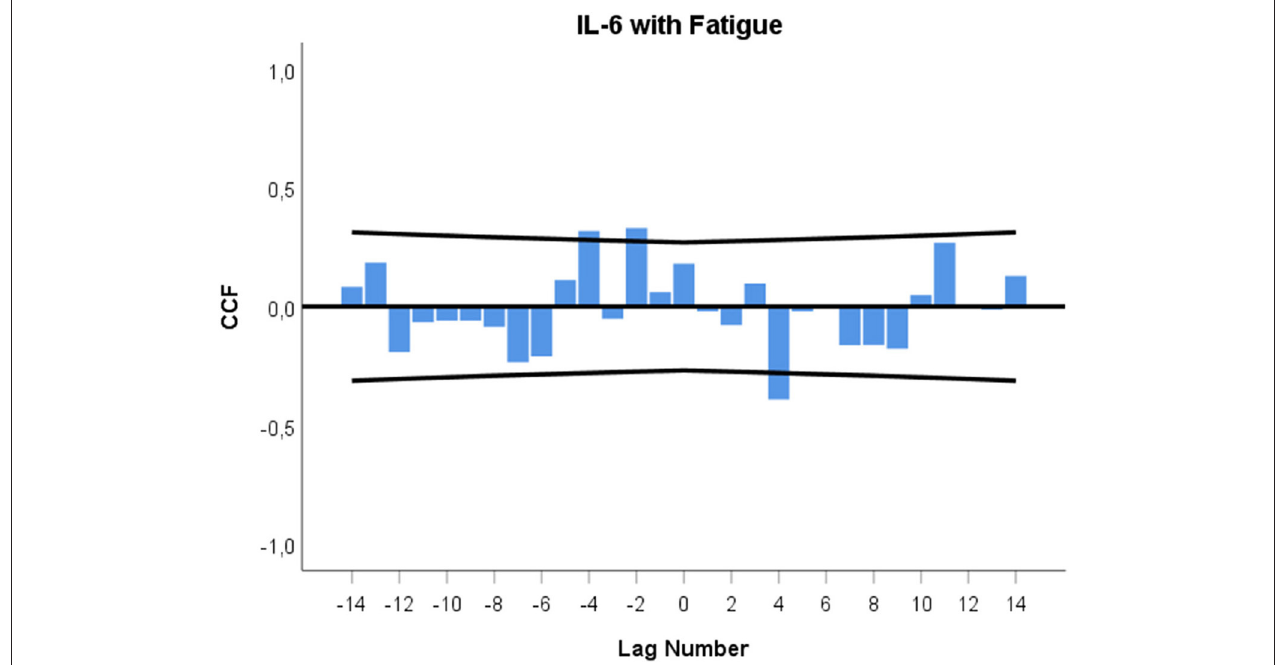
FIGURE 5 | Cross-correlation function (CCF) between urinary IL-6 concentrations and fatigue levels. Each lag represents a time interval of 12h. Cross-correlation coefficients (bars) reaching the upper or lower confidence limits (lines) are significant at p < 0.05. A positive lag significance means that IL-6 changes precede fatigue changes. A negative lag significance means that fatigue changes precede IL-6